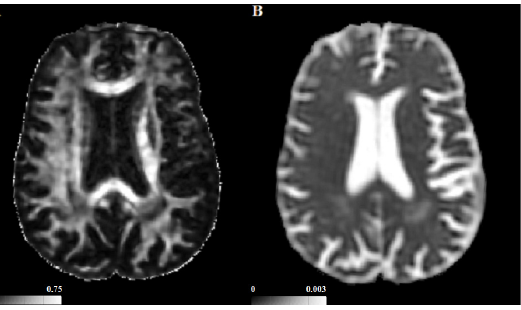
Fig 3. A. An axial fractional anisotropy and B. mean diffusivity map (mm 2 s -1 ). Images are from a 78 year old male from the SCANS cohort and representative of DTI-derived maps of symptomatic cerebral small vessel disease